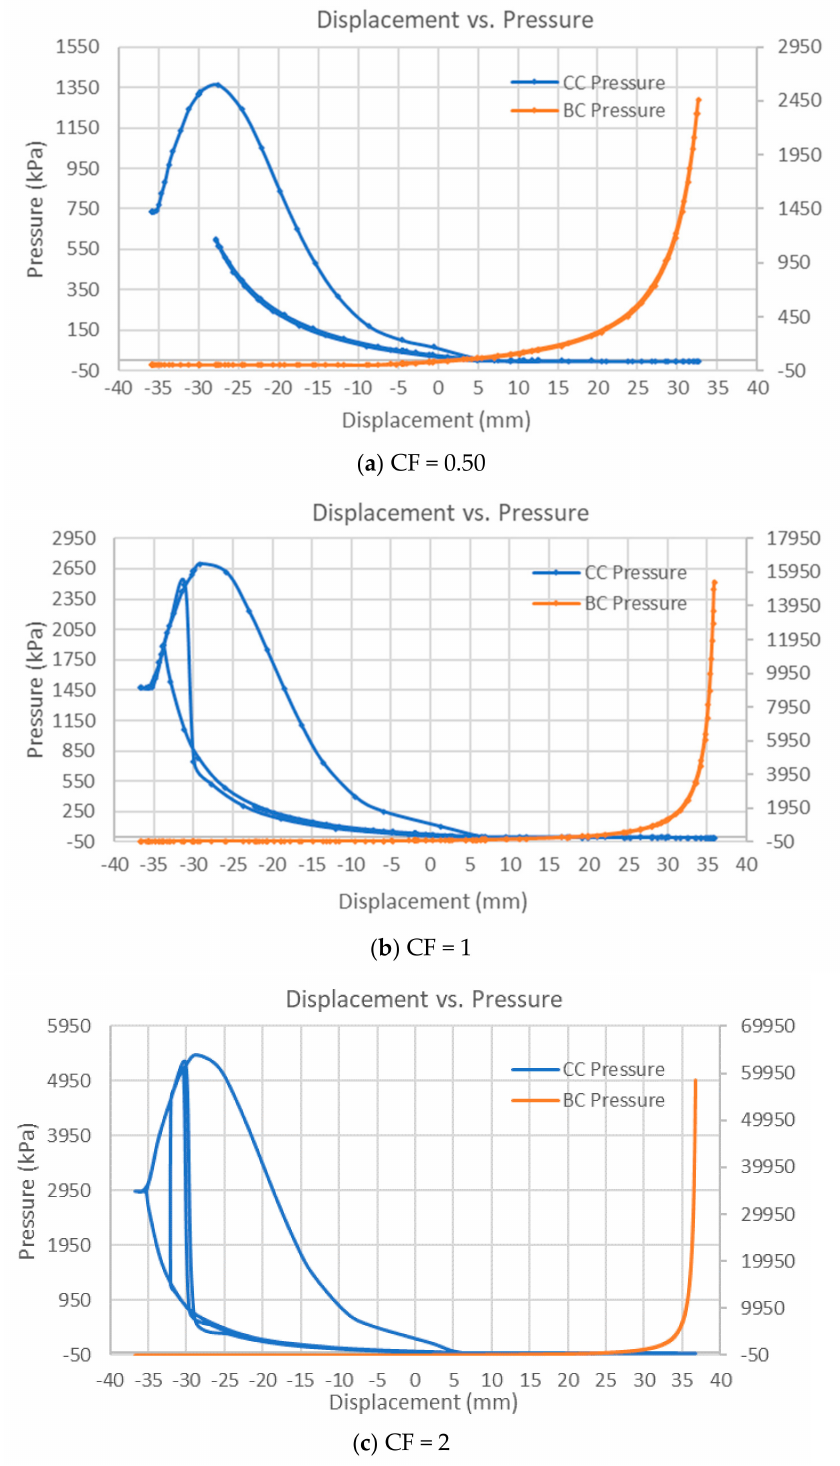
Figure 13. Loaded operation with improved simulation model: pressure vs. displacement